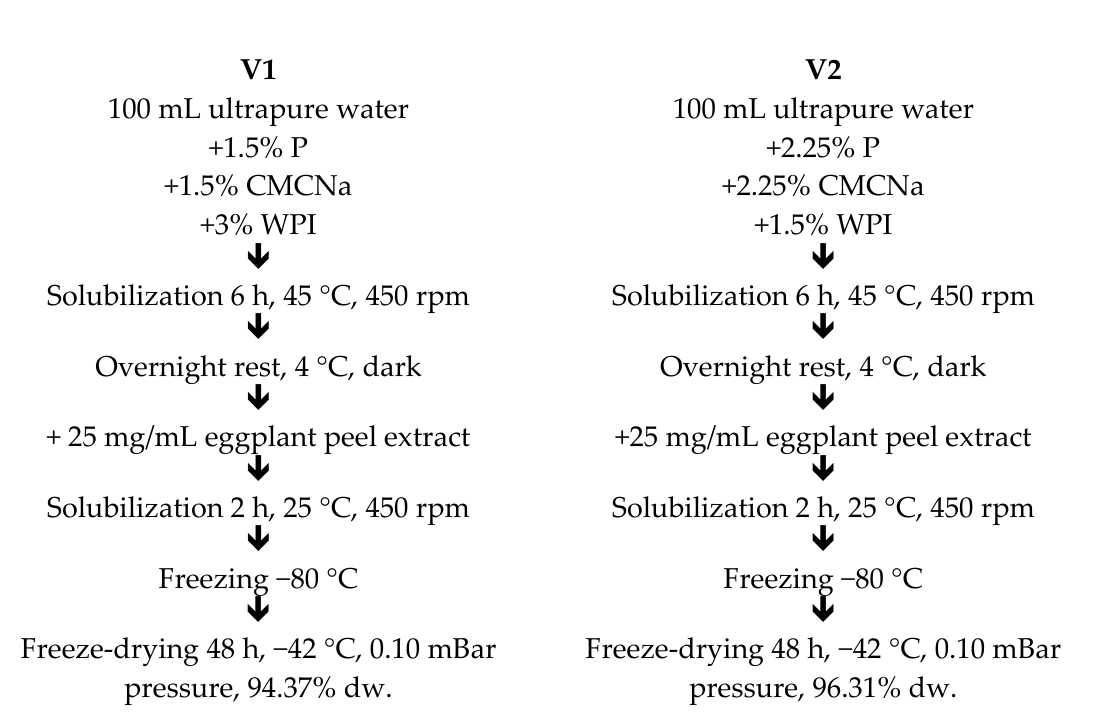
Figure 1. The eggplant peel extract encapsulation scheme using the gelation technique .